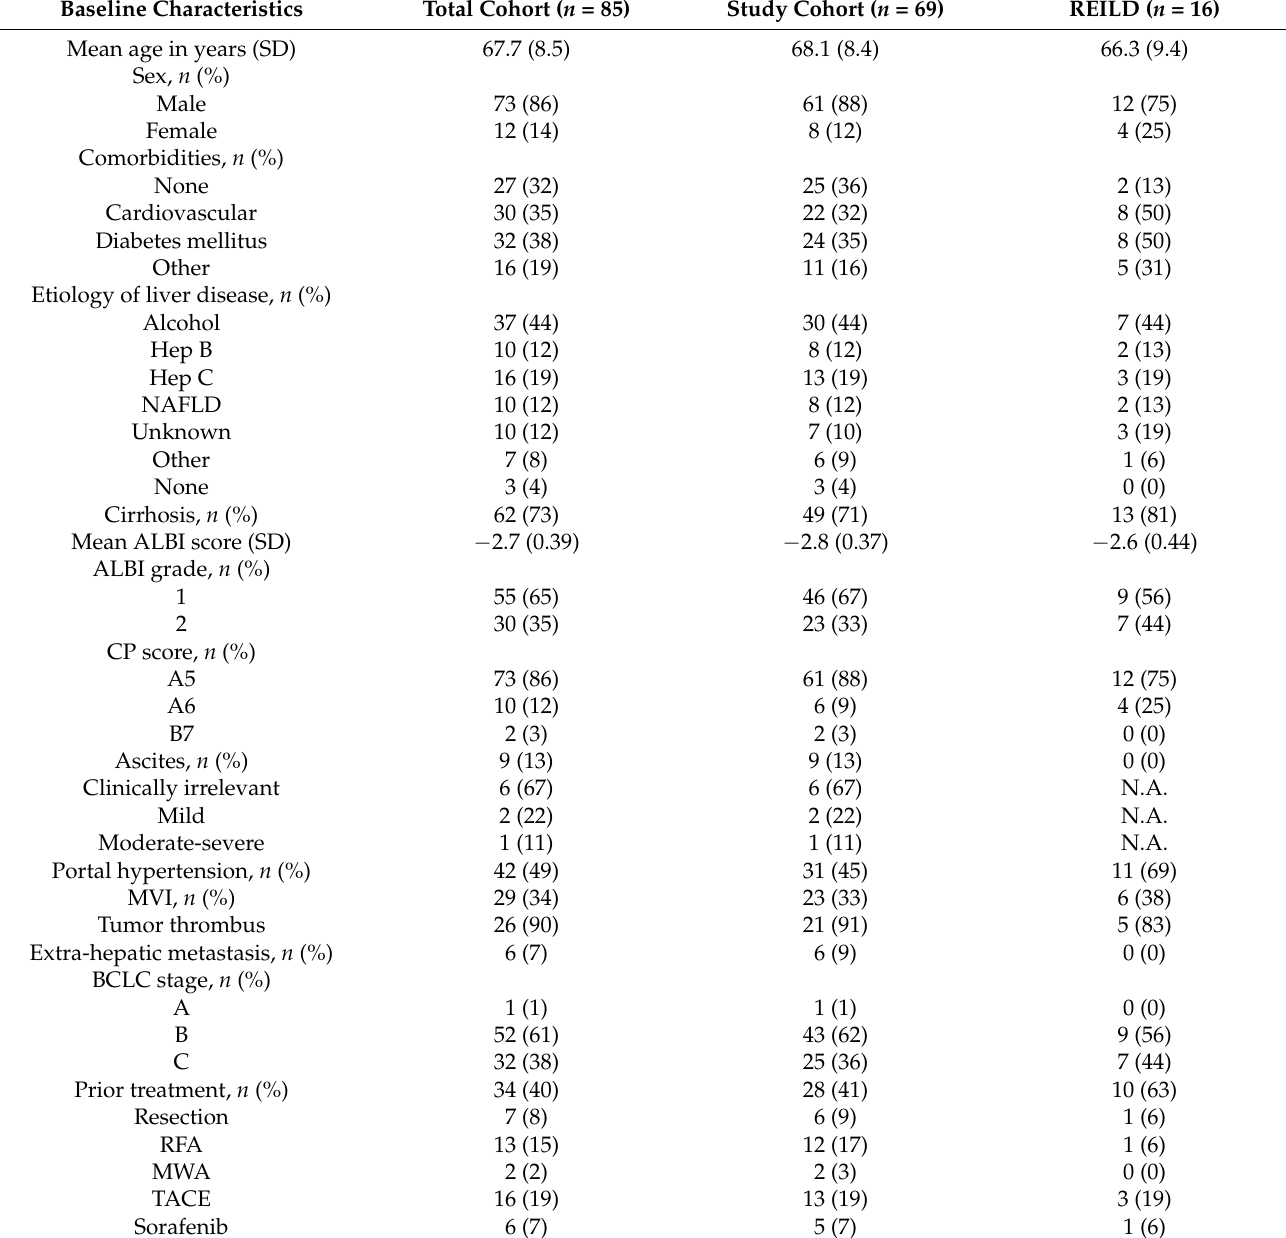
Table 1. Baseline, treatment and previous treatment characteristics of patients treated with